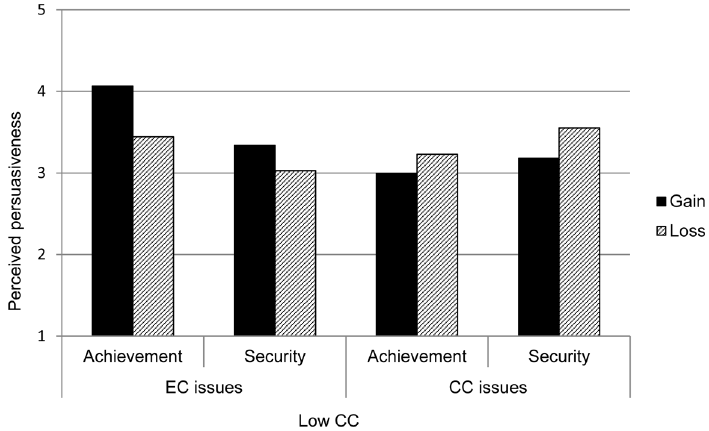
Figure 4a. Perceived persuasiveness as a function of type of issue, type of benefit and outcome focus under low cultural conservatism (Study